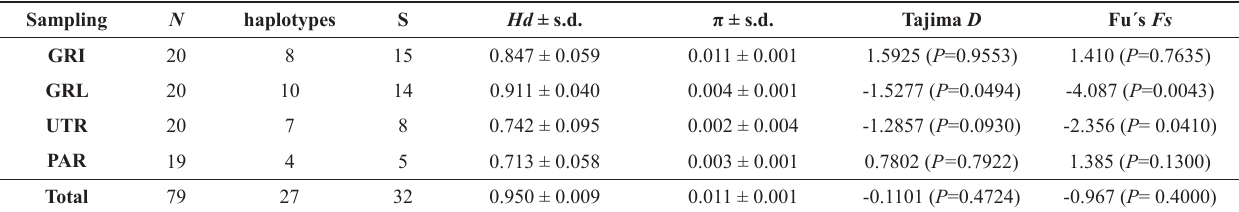
Table 2 . Mitochondrial DNA sampling and descriptive statistics for Salminus hilarii . ( N ) = number of sequenced individuals; ( S ) = number of polymorphic sites; ( Hd ) haplotype diversity; (π) nucleotide diversity; (s.d.) standard